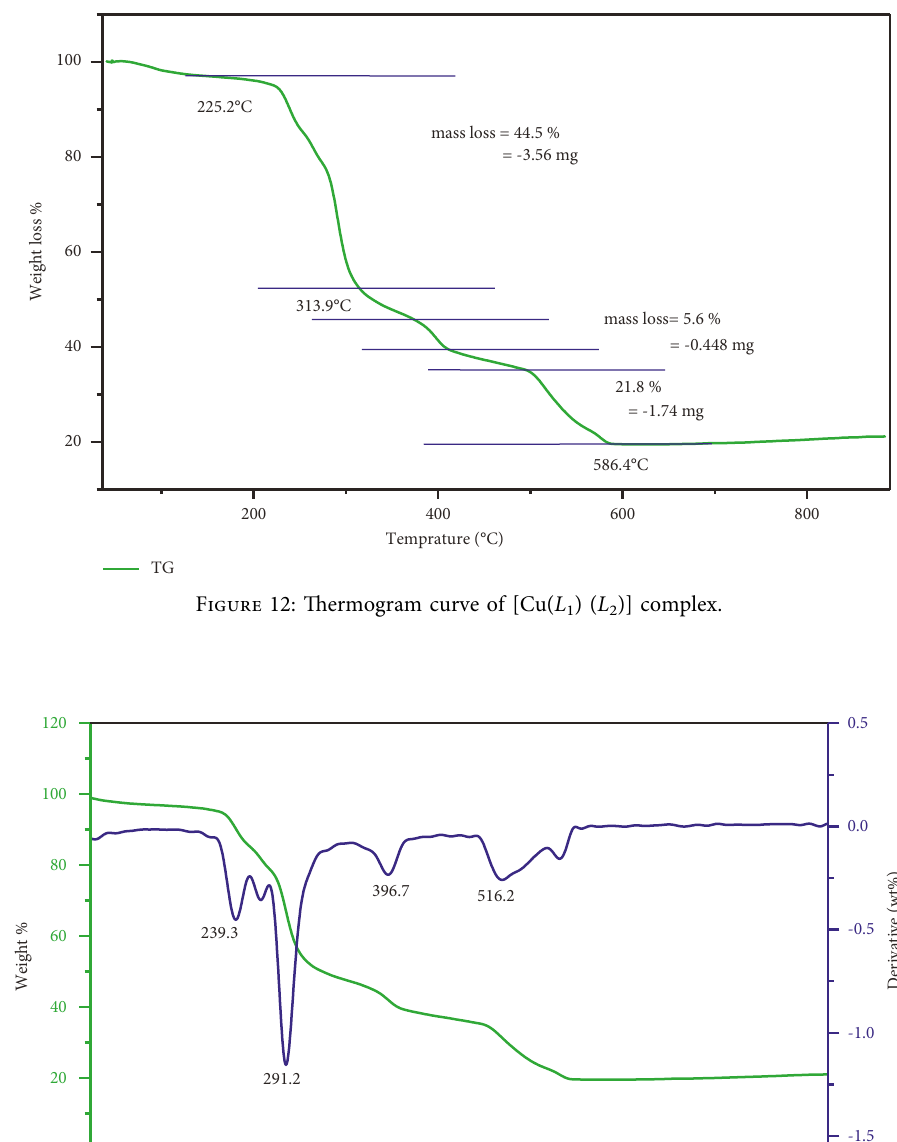
Figure 13: TG-DTG graph of [Cu( L